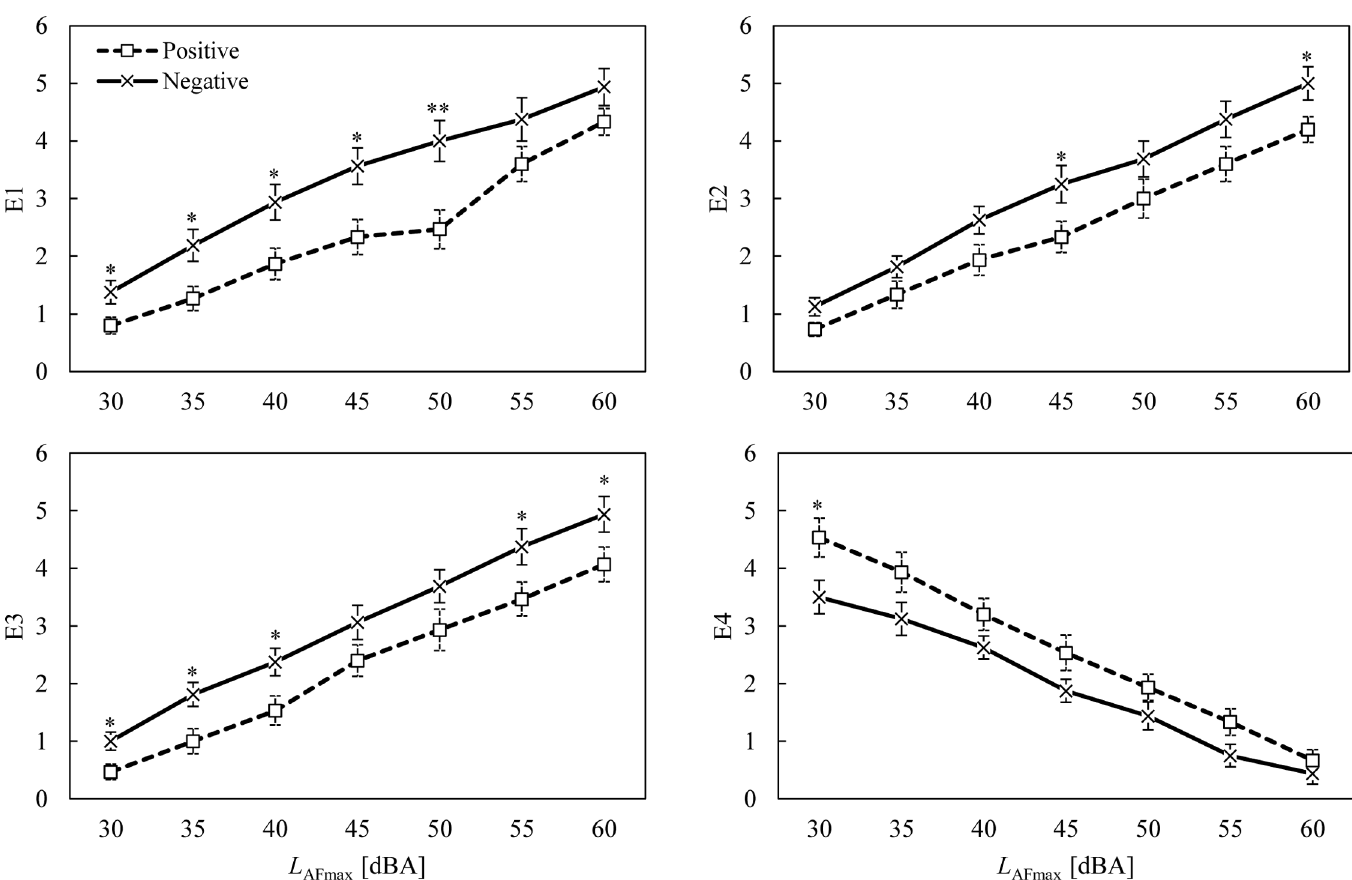
Fig 2. Ratings of perceived emotions for positive ( □ ) and negative ( × ) attitude groups as a function of noise level. Error bars indicate standard errors. Asterisks indicate significant differences between means according to the Mann-Whitney U test ( (cid:3) p < 0.05 and (cid:3)(cid:3) p < 0.01).